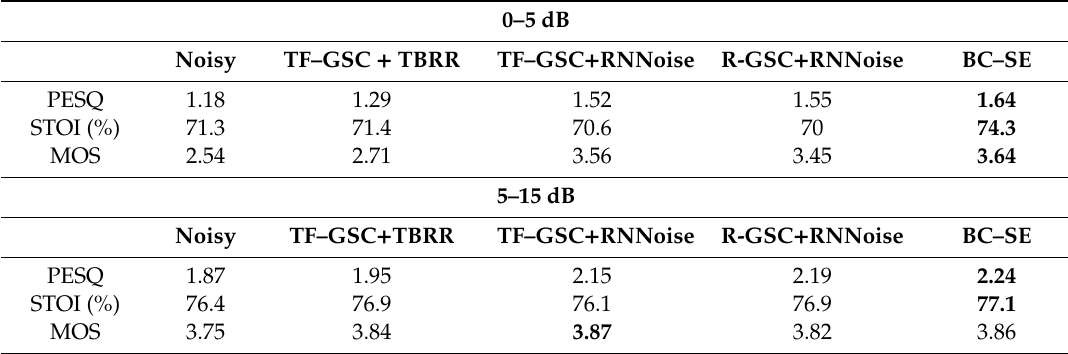
Table 2. The objective and subjective measurements comparing the PESQ and MOS